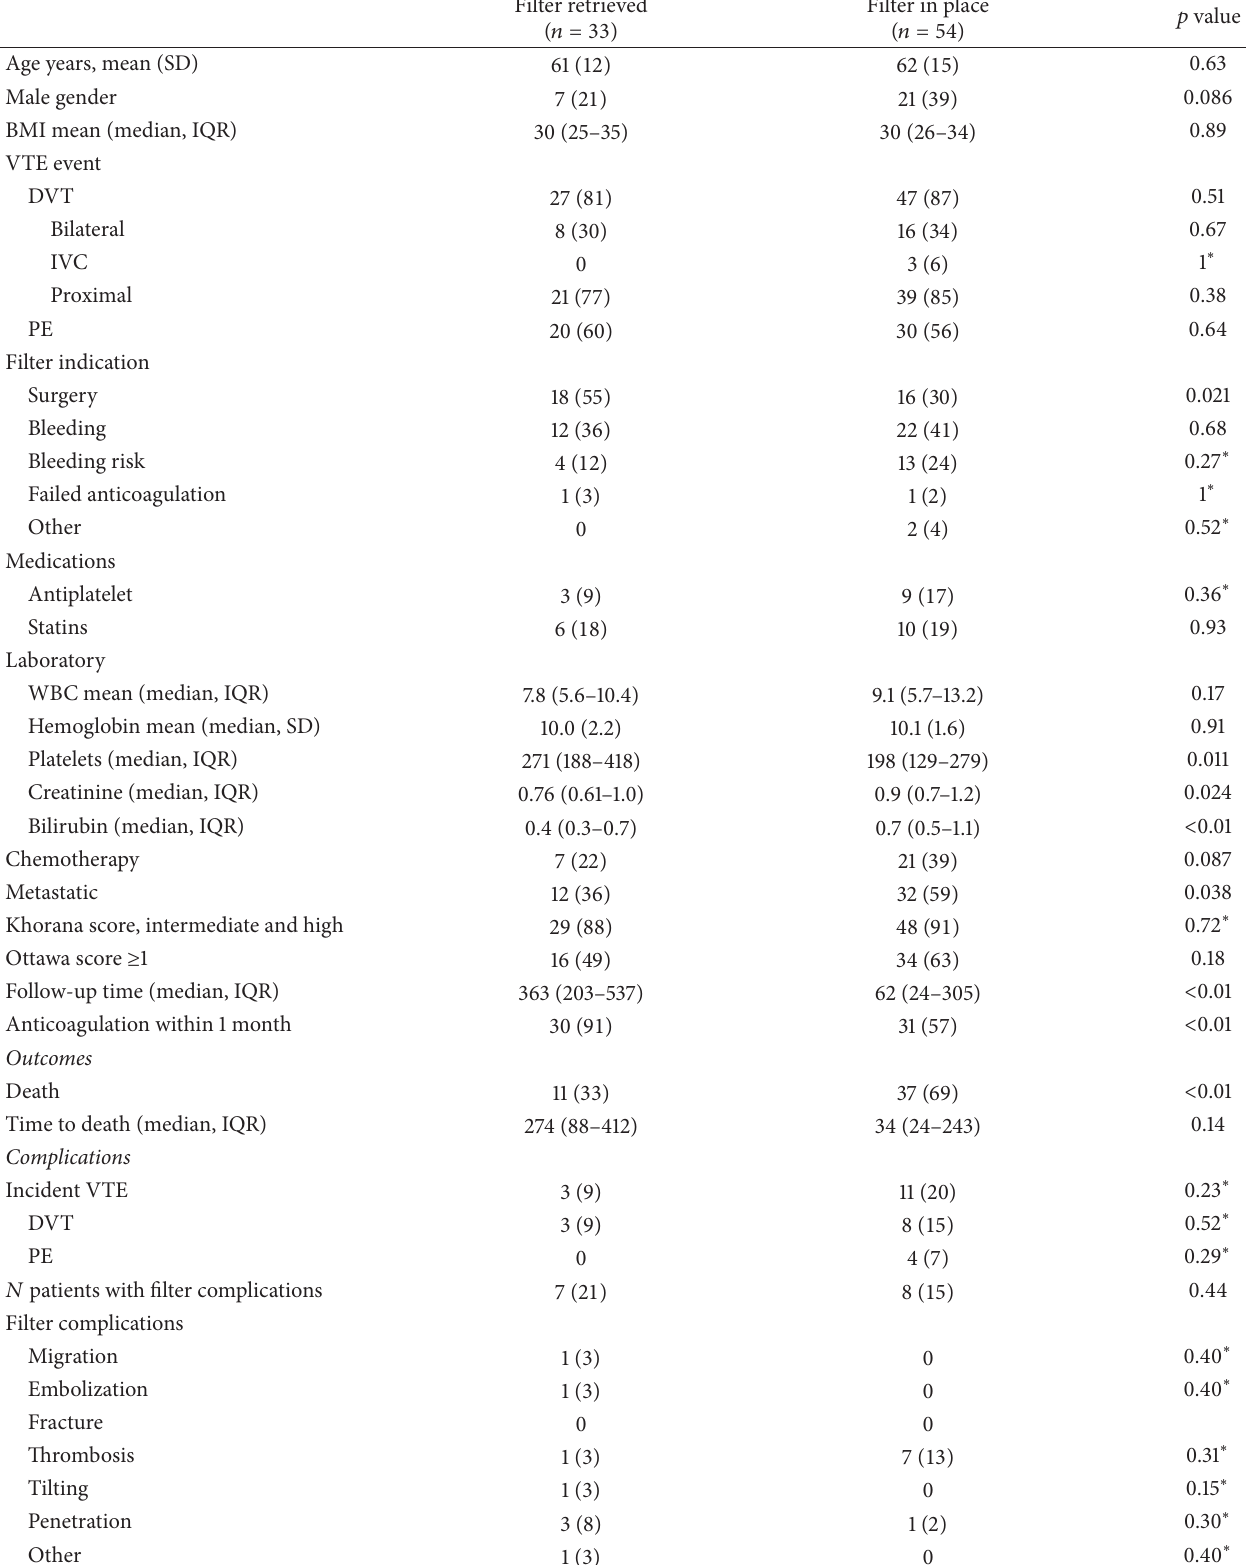
Table 4: Clinical characteristics in patients with active cancer ( 𝑛 = 87 ) with and without filter